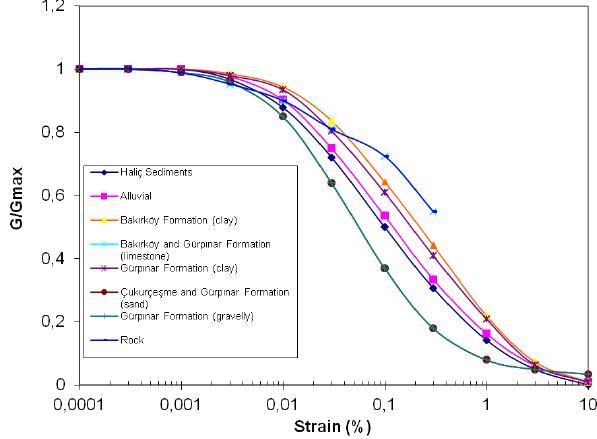
Figure 9. Damping Ratio and Shear Strain relationships for all formations. Figure 9. Damping ratio and shear strain relationships for all